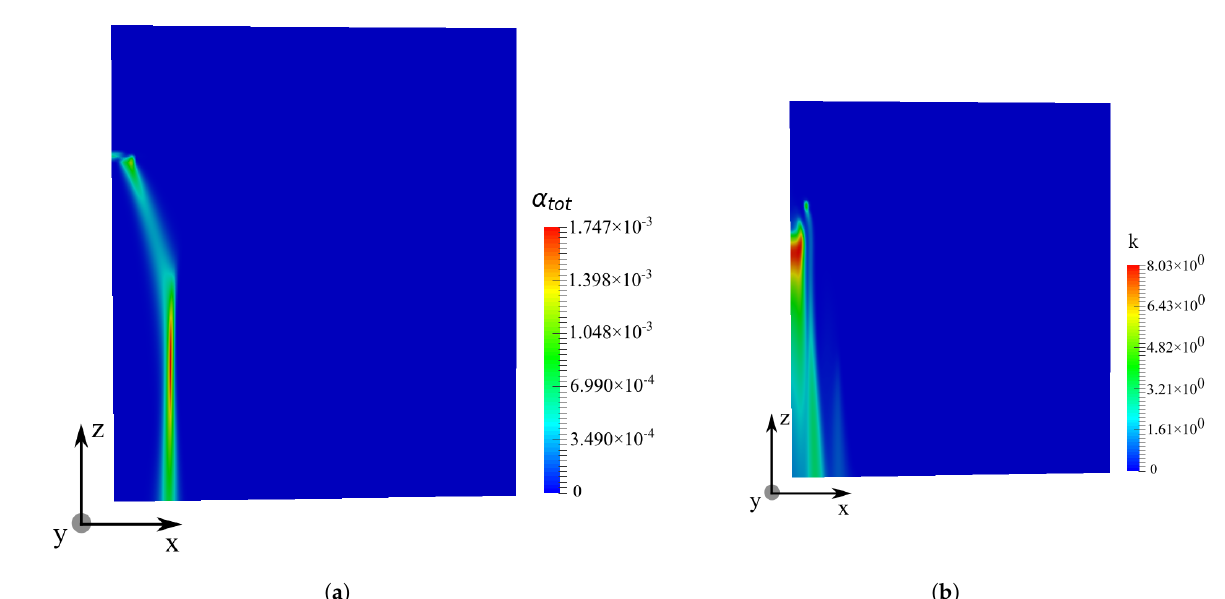
Figure 8. Spatial distribution of the properties on XZ plane at y = 0.05 m for a monodisperse spray, t = 10 s, ∆ x = 1.5 cm, ∆ t = 1 ms; ( a ) droplet volume fraction α 2 /s 2 ). tot and ( b ) turbulent kinetic energy k (m